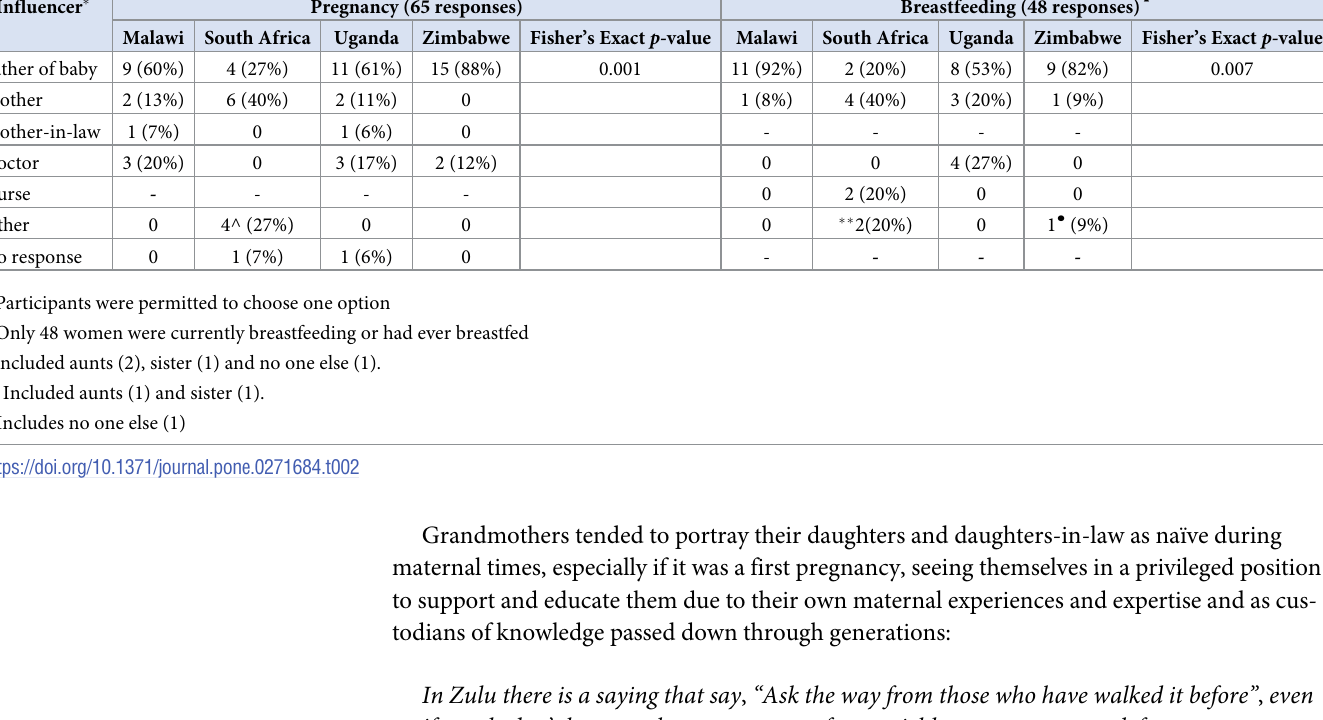
Table 2. Pregnant and breastfeeding women’s responses when asked about who has the most influence on their decisions during pregnancy and while breastfeeding besides themselves. Influencer